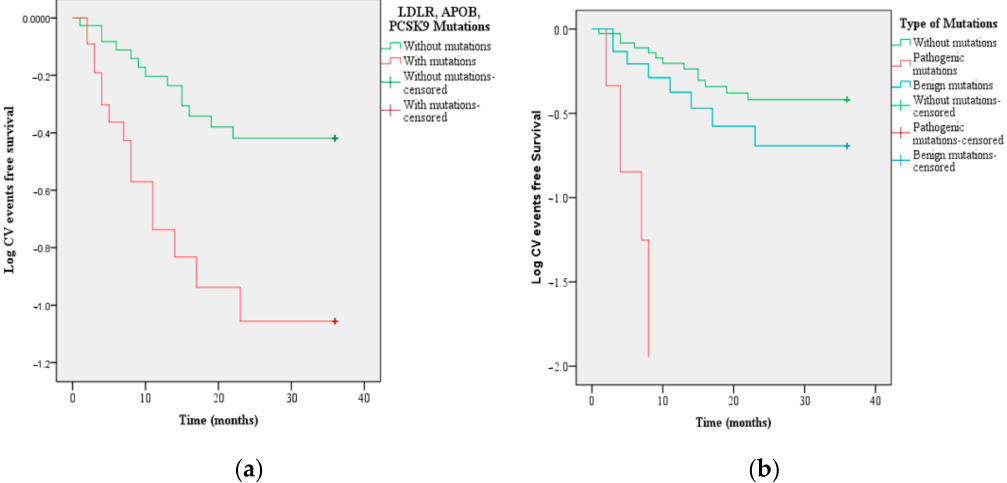
Figure 6. Kaplan-Meier for ASCVD depending on ( a ) LDLR , APOB, and PCSK9 mutations and ( b ) clinical significance of FH-associated variants and time interval for the occurrence of new CV events. Legend: LDLR—low-density cholesterol lipoprotein receptor, APOB—apolipoprotein B, PCSK9—proprotein convertase subtilisin/kexin type 9,